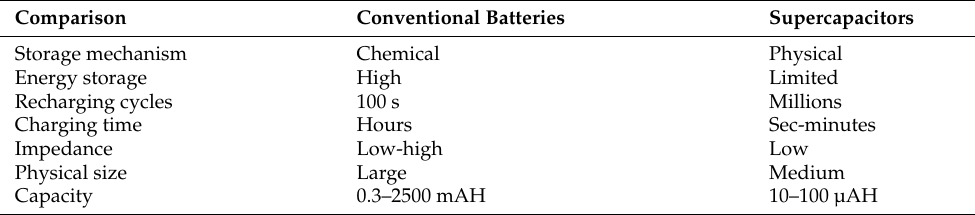
Table 6. Comparison between different storage techniques for energy harvesters in IoMT devices